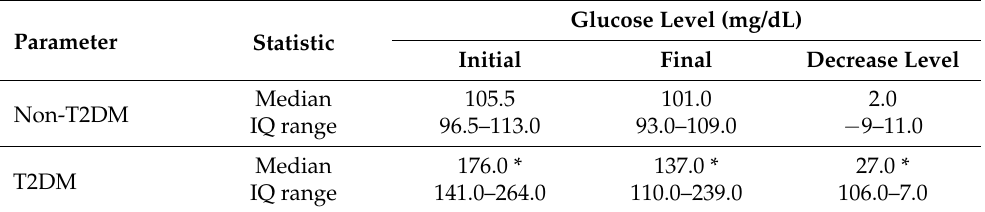
Figure 1. Distribution of changes in the FibroMax test scores after DAA treatment in non-T2DM patients versus in T2DM patients. Based on the ActiTest results, a successful treatment led to the overall improvement of inflammation scores except in a few patients. The patients showed significant improve- Table 4. FastingglucoselevelsbeforeandafterDAAtreatmentinnon-T2DMpatientsvs. ment. On average, the difference between the initial scores and post-treatment revealed a